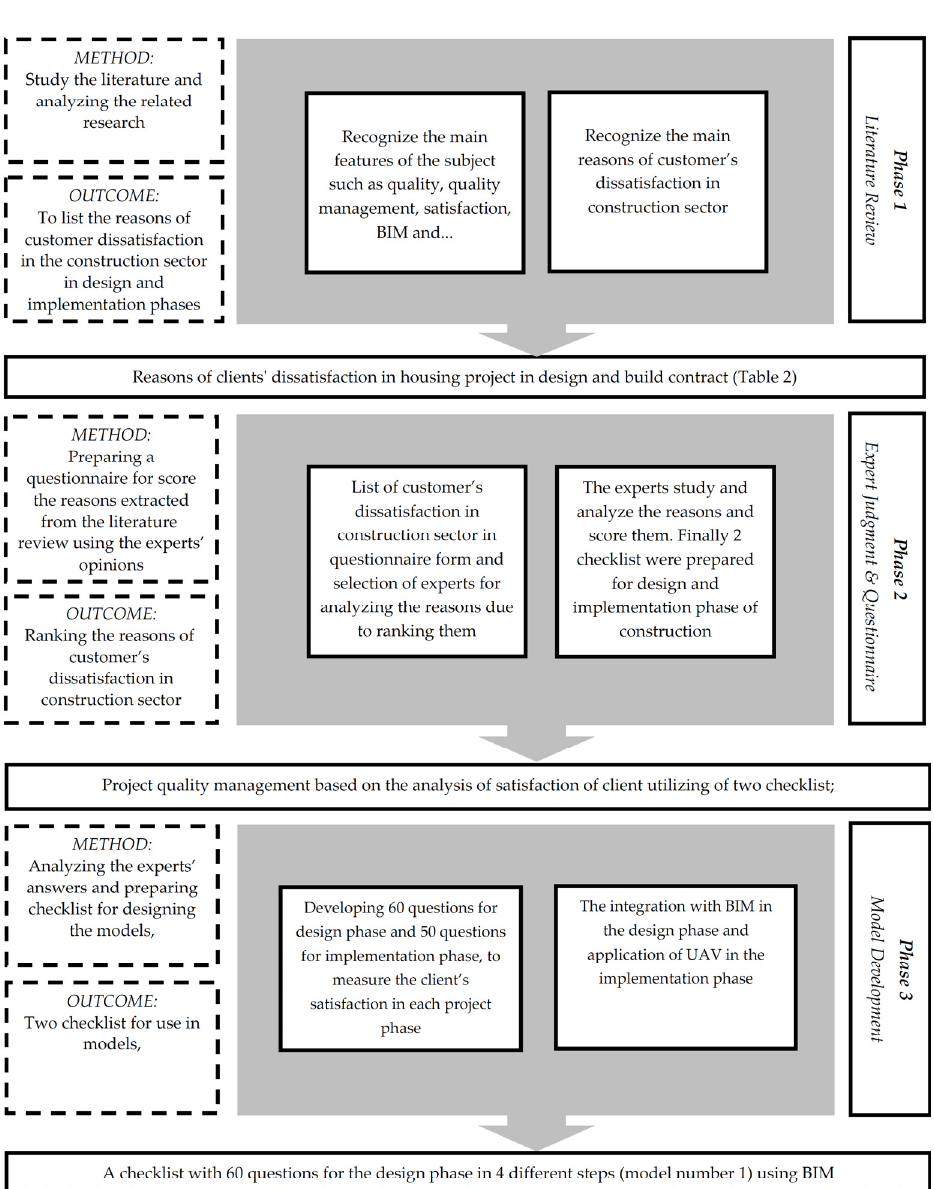
Figure 1. Overview of different phases of research.